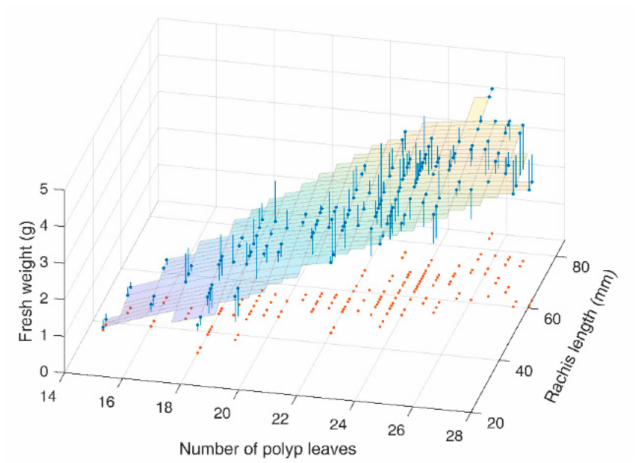
Figure 6. The behavior of fresh weight as a function of both the number of polyp leaves and rachis length in Pennatula rubra . Blue bars represent errors between measured weight and least squares surface fitting. Red dots are projections on the horizontal plane.